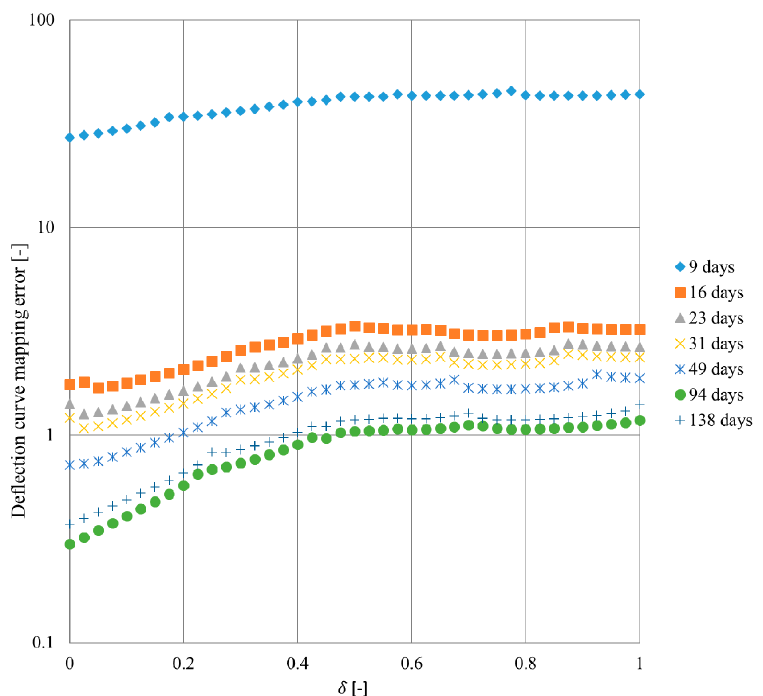
δ parameter (4R—taking into